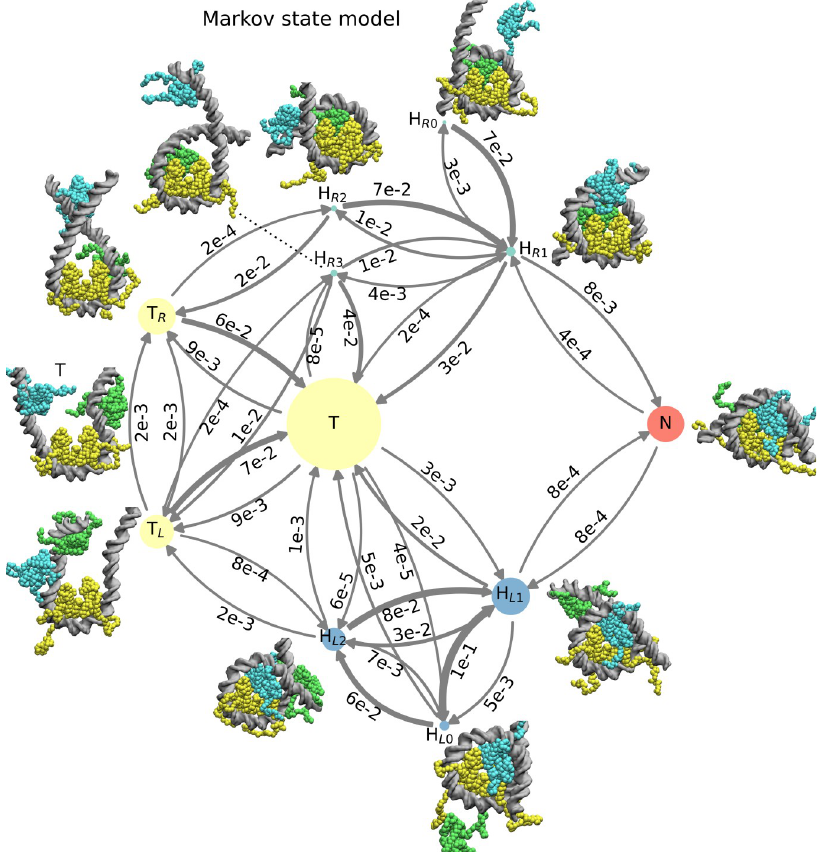
Fig 2. Markov state model of nucleosome assembly. We show the 11 metastable basins identified by PCCA clustering from the MSM at 400 mM, indicating their corresponding representative structures, and the transitions probabilities among the basins. The nodes of the tetrasome (T, T L , T R ), left hexasome (H L0 , H L1 , H L2 ), right hexasome (H R0 , H R1 , H R2 , H R3 ), and nucleosome (N) basins, are respectively colored in yellow, blue, cyan and red. The areas of the nodes are proportional to their equilibrium populations. The transition probabilities between basins are represented by the thickness of arrows and the numbers associated (e.g., 3e-2 stands for 3x10 -2 ).